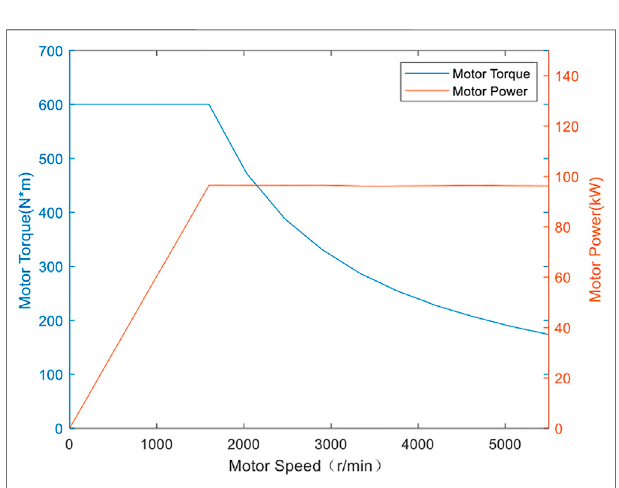
FIGURE 2 | External characteristic diagram of the motor.